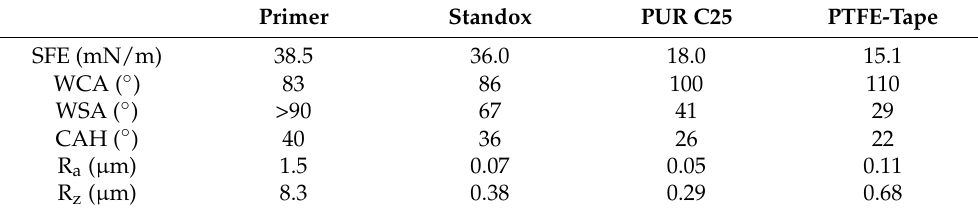
Table 2. Summary of the surface characterization data for the used materials.